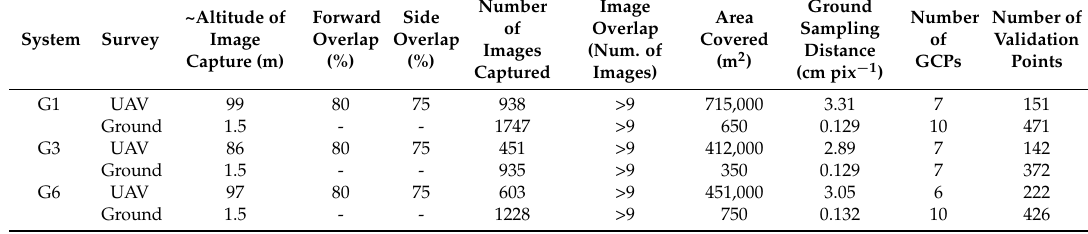
Table 2. UAV and ground survey details.